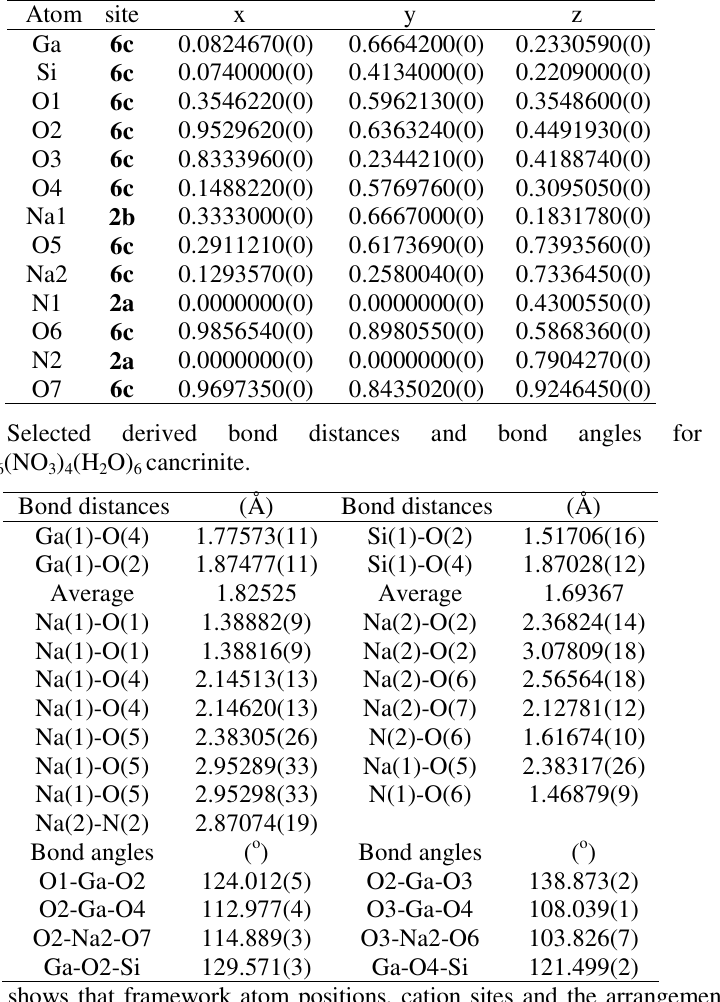
Table 2. Fractional coordinates and equivalent displacement parameters of nitrate cancrinite.